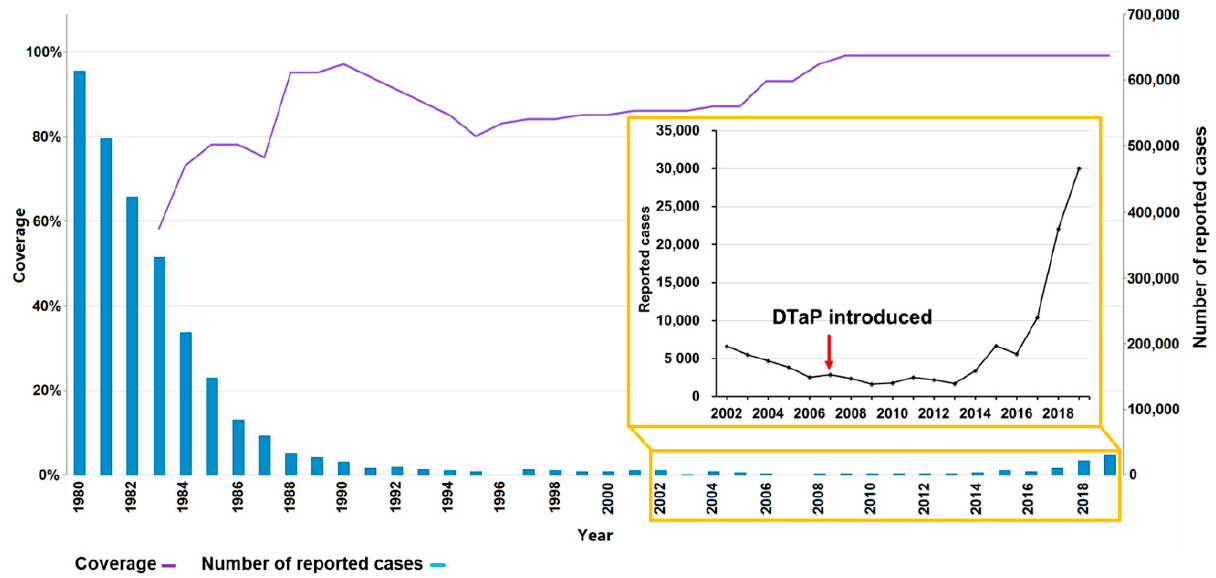
Figure 1. DTP3 vaccination coverage and number of reported pertussis cases in China, 1980–2019 [2,3]. DTP3: diphtheria and tetanus toxoids and pertussis (DTP)-containing vaccine, 3rd dose. This is an adaptation of an original work “Comparison of Immunization coverage for Diphtheria Tetanus Toxoid and Pertussis (DTP) vaccination coverage and Reported cases for Pertussis. Geneva: World Health Organization (WHO); 2021. Licence: CC BY-NC-SA 3.0 IGO“